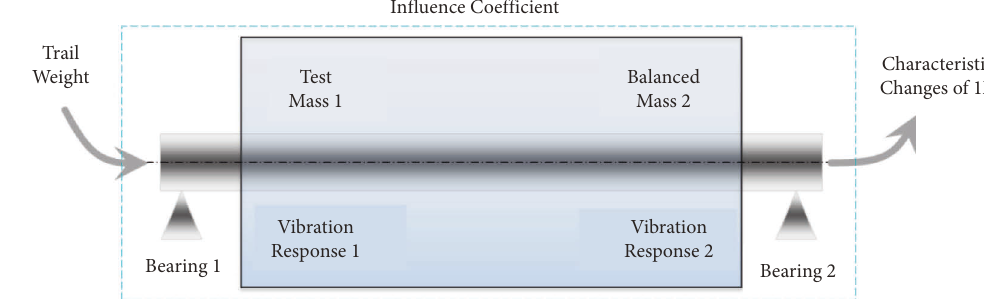
Figure 1: The influence coefficient calculation model.